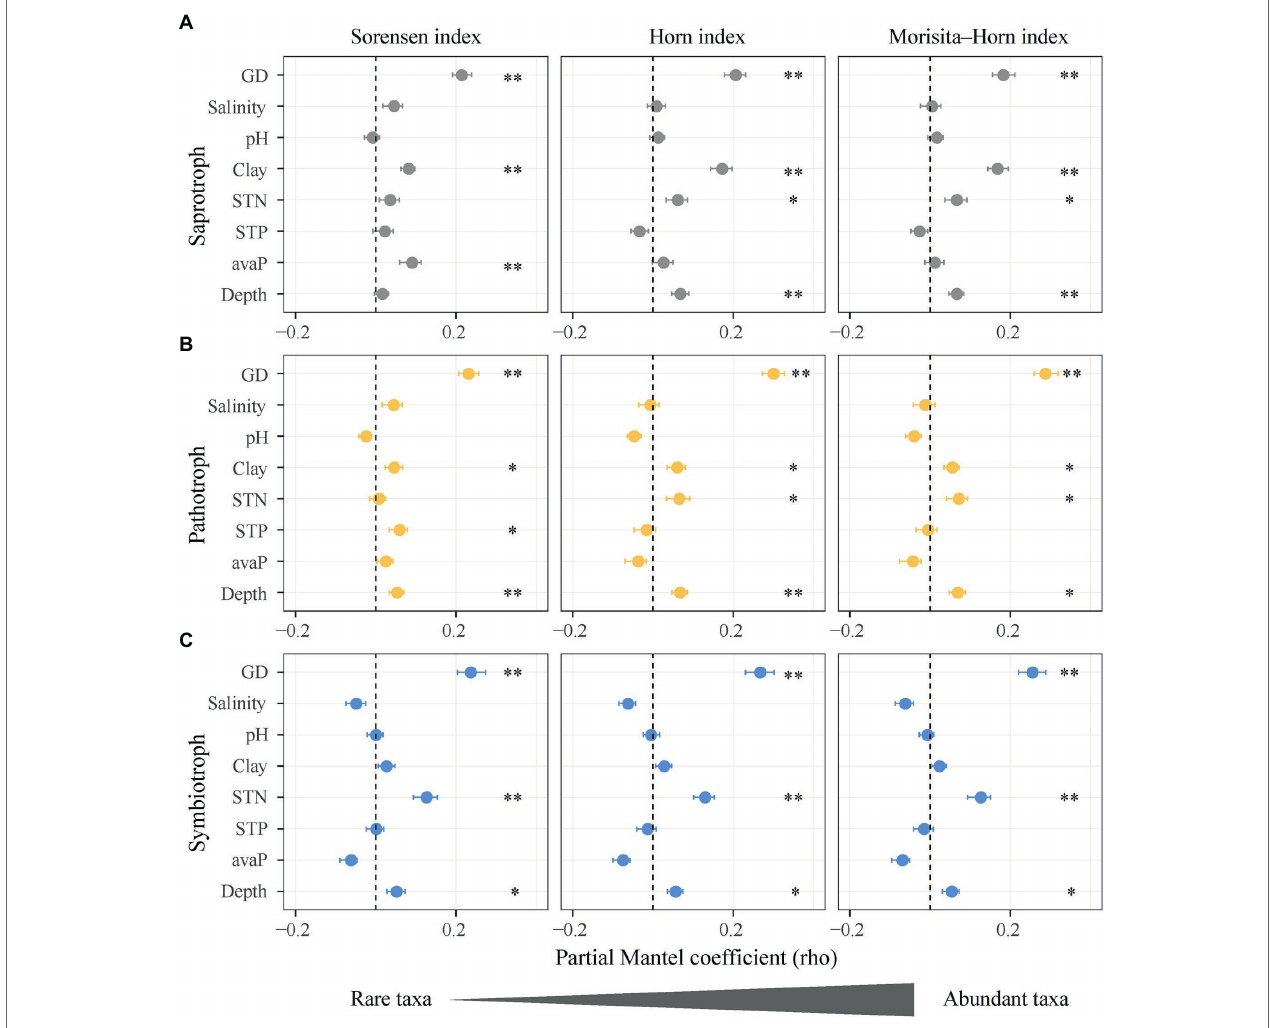
FIGURE 5 | Impacts of soil salinity, geographic distance, and soil properties on the community composition of functional guilds of soil fungi. (A) Saprotrophic fungi; (B) pathotrophic fungi; (C) symbiotrophic fungi. Points denote partial Mantel coefficients and error bars denote 95% confidence intervals. * p < 0.05; ** p < 0.01. Abbreviations: GD, geographic distance; Salinity, soil salinity; STN, soil total nitrogen; Clay, soil clay content; STP, soil total phosphorus; avaP, soil available phosphorus; Depth, soil